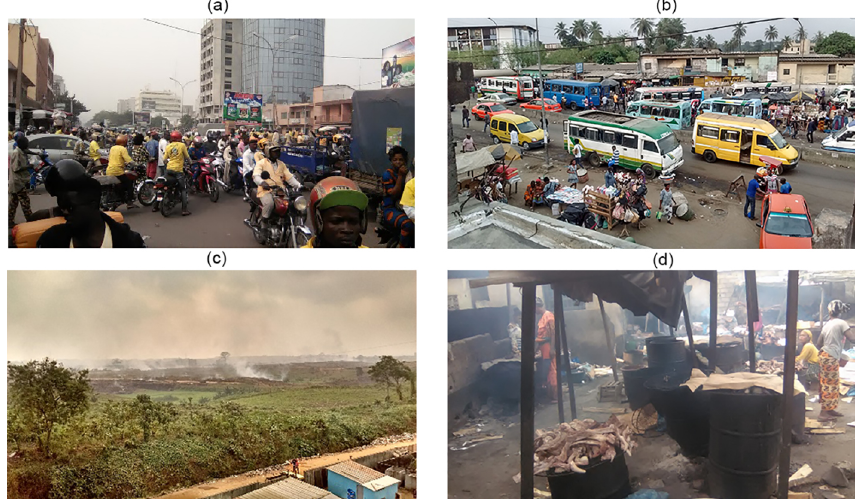
Figure 4. Pictures showing the immediate environment of the stations: (a) two-wheel traffic in Cotonou (CT station), (b) small-bus traffic in Abidjan (AT station), (c) waste burning at the Abidjan landfill (AL station), (d) smoking activity in Abidjan–Yopougon (ADF